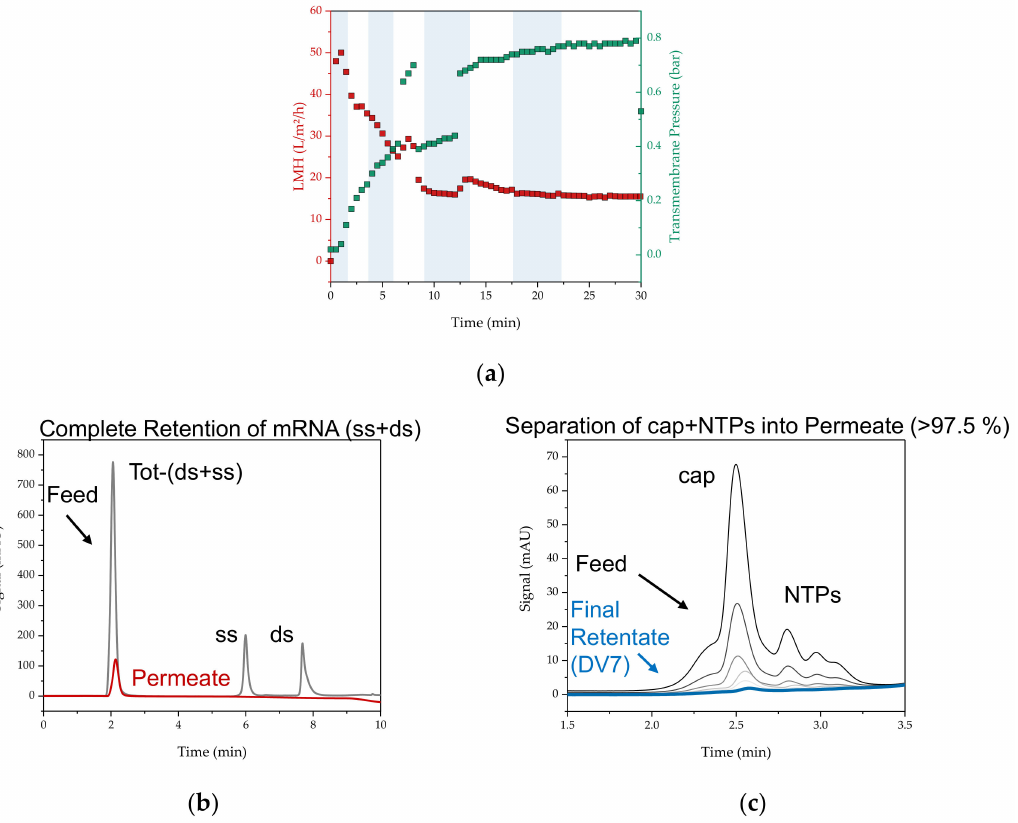
Figure 23. ( a ) Course of UFDF (LMH and TMP); ( b ) analysis of permeate and feed by RP; and ( c ) PrimaS chromatography.